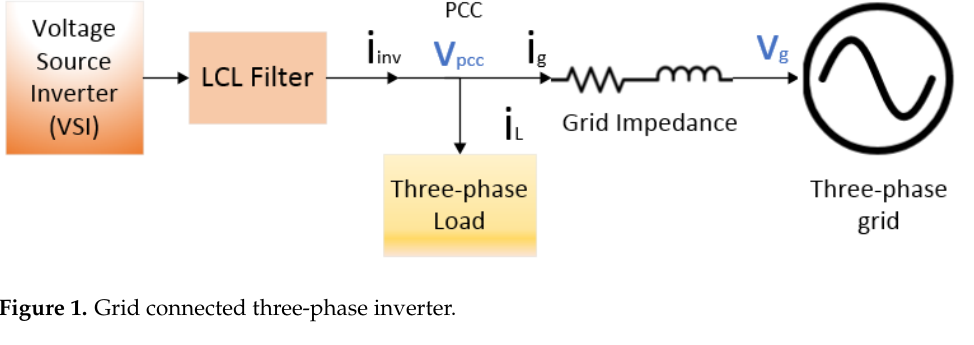
Figure 1. Grid connected three-phase